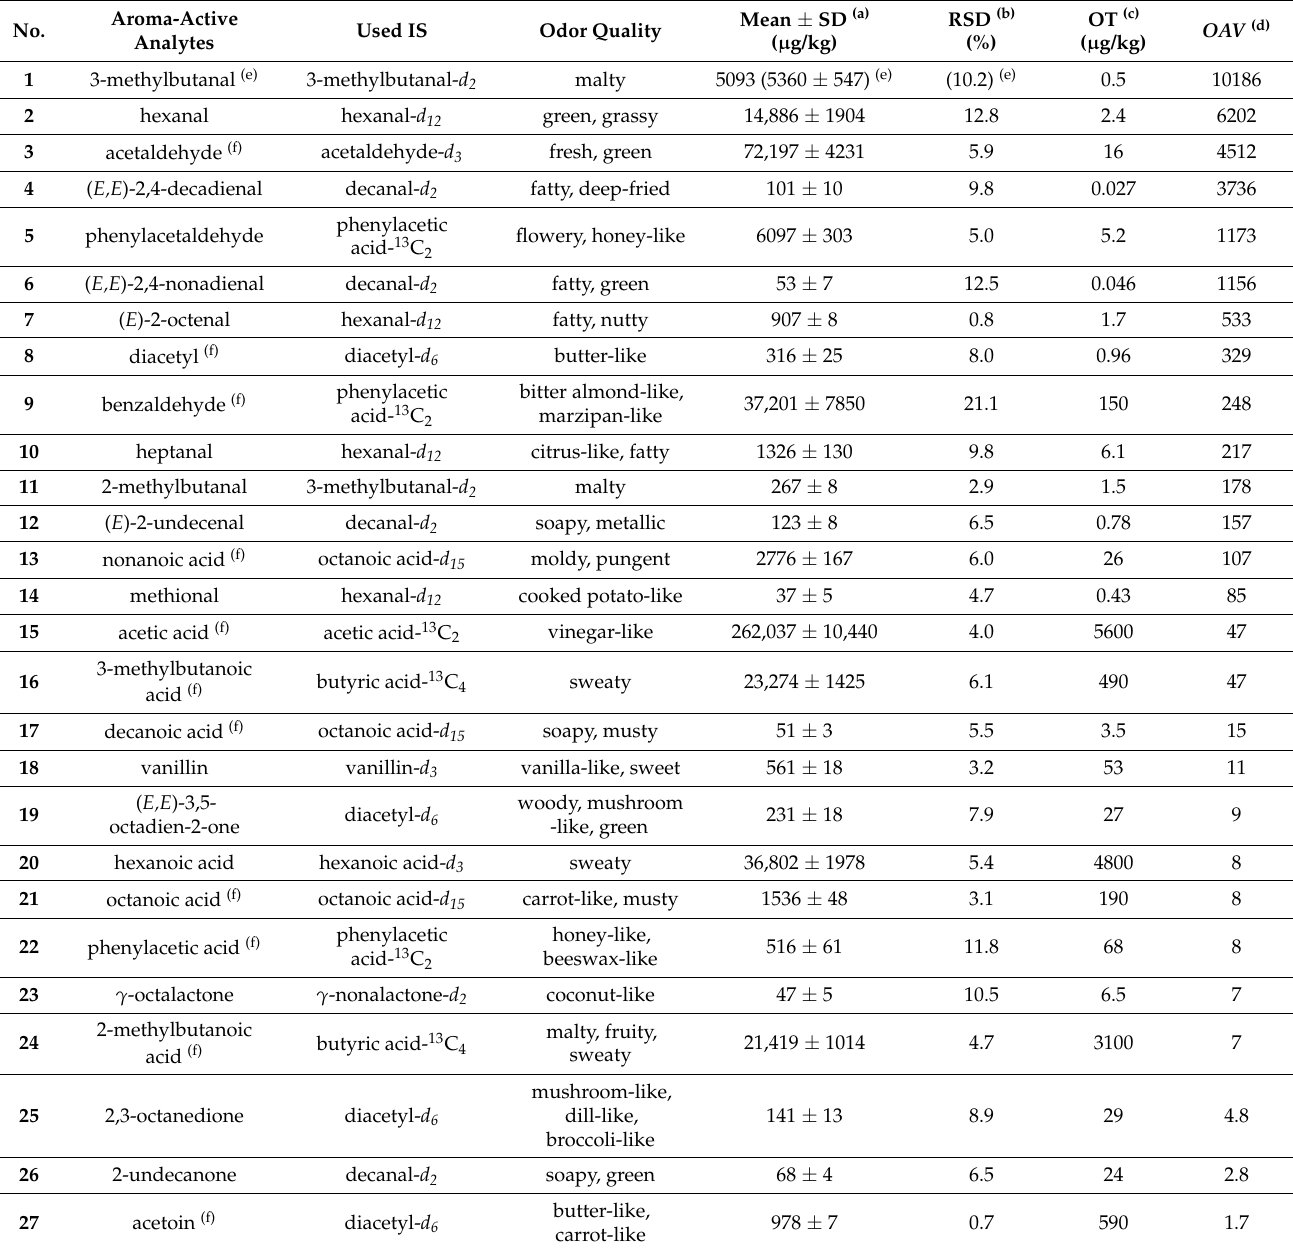
Table 3. Concentrations of aroma-active compounds in pea protein C in descending OAV